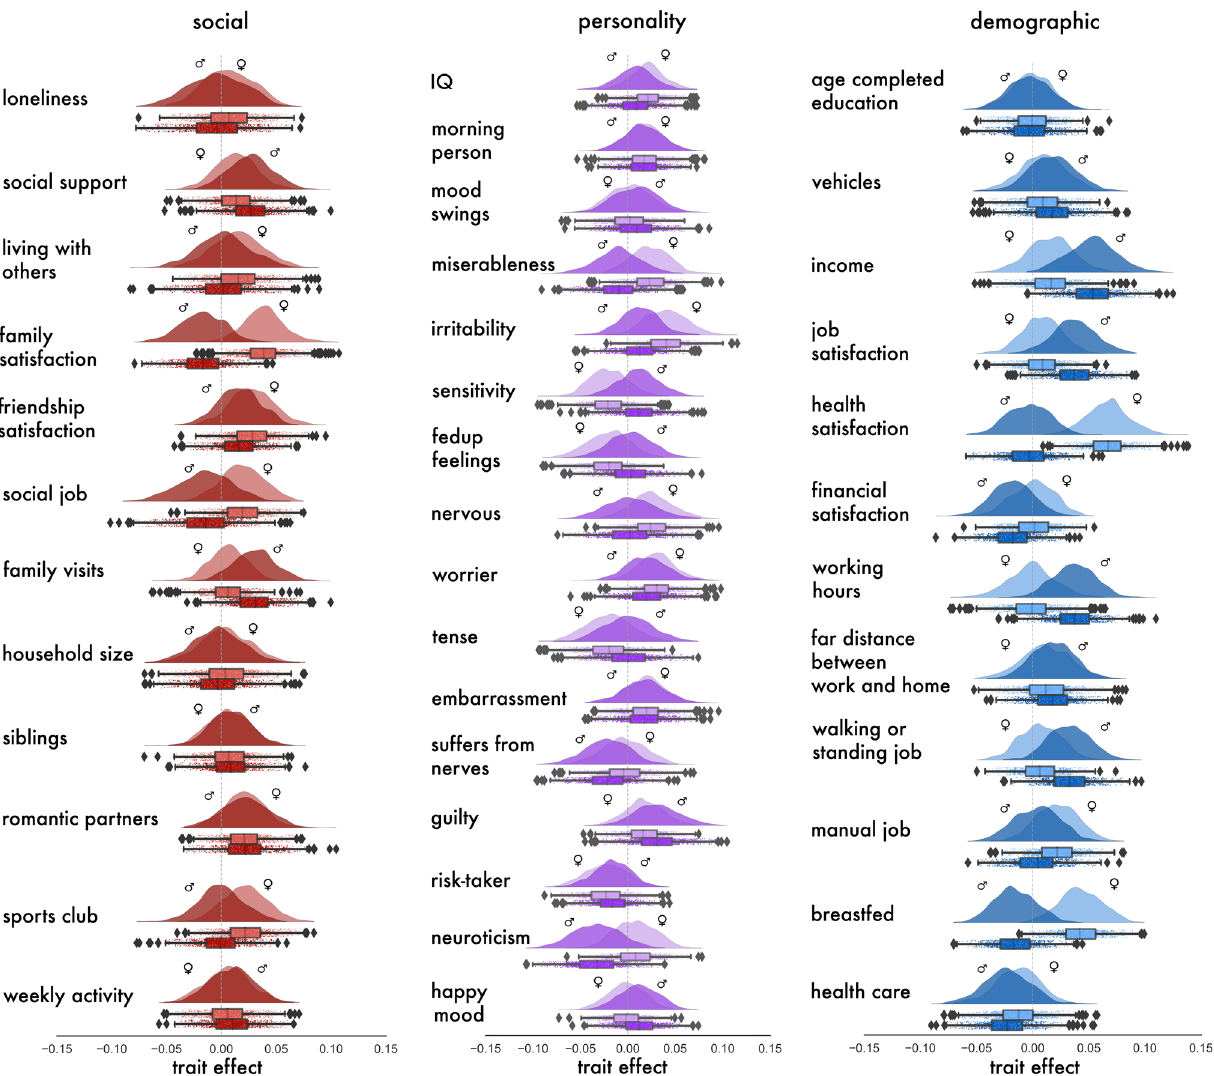
Fig. 2 vmPFC anatomy is linked to social lifestyle markers of social, personality, and demographic traits with sex-differentiated population effects. During midlife, regions of the mPFC have been found to show an accelerated decline in gray matter structure (cf. introduction). For the sake of illustration, the marginal posterior population distributions from our vmPFC analysis are depicted using raincloud plots (1 of the 36 region-by-region analyses that we have conducted on the UK Biobank). We reveal to what extent vmPFC region volume is speci fi cally explained by the 40 examined lifestyle traits at the population level (cf. Supplementary Data 1). The half violin plots show the posterior parameter distributions of the speci fi c contributions of each single trait to vmPFC volume, not explained by the other traits, in middle-aged men and women. The boxplots and scatterplots underneath depict the probabilistic parameter guesses that together form the marginal posterior distributions. Each brain-behavior HPDI communicates three kinds of information: direction (e.g., a positive parameter value indicates a tendency for a higher brain volume in the presence of that particular trait), magnitude (e.g., a parameter mean further above or below zero indicates a bigger dependence of region volume on that particular trait), and certainty (e.g., a narrower interval indicates that the model is more sure about the estimated direction and magnitude of a particular brain-behavior effect). For middle-aged women, satisfaction with health contributed most to explaining vmPFC region volume. In contrast, for middle-aged men, earning a higher job income explained most vmPFC gray matter volume. Error bars/dispersion shows uncertainty of Bayesian posterior parameter distributions. Source data are provided in Supplementary Data contribute to social brain volume in regions of the visual sensory, personality category, markers associated with daily routines and limbic, and intermediate brain networks (women: FG_R: posterior psychological well-being showed large magnitudes in explaining gray mean = − 0.015, 95% HPDI = − 0.036 – 0.004; IFG_L: posterior matter volume (Fig. 1). In general, the personality trait of being a mean = − 0.004, HPDI = − 0.020 – 0.008; NAC_R: posterior mean morning versus evening person explained the largest fraction of = − 0.008, HPDI = − 0.025 – 0.007; SMA_L: posterior mean = volume variation in 11 different social brain regions, compared to the − 0.010, HPDI = − 0.031 – 0.009). As such, our social trait fi ndings other candidate traits (Fig. 1). This biorhythm indicator showed from the partial correlation analysis here identi fi ed a similar set of dominant trait effects in regions of the intermediate network of our dominant trait associations to that of the main analysis. social brain atlas, including the AI_R (men: posterior mean = 0.050, 95% HPDI = 0.015 – 0.089), bilateral CB (men: CB_L: posterior mean = 0.069, HPDI = 0.016 – 0.123; CB_R: posterior mean = 0.083, HPDI Personality markers: top brain associations are explained by = 0.028 – 0.140), SMA_L (men: posterior mean = 0.056, HPDI = daily routine and well-being . Focusing on trait effects from the